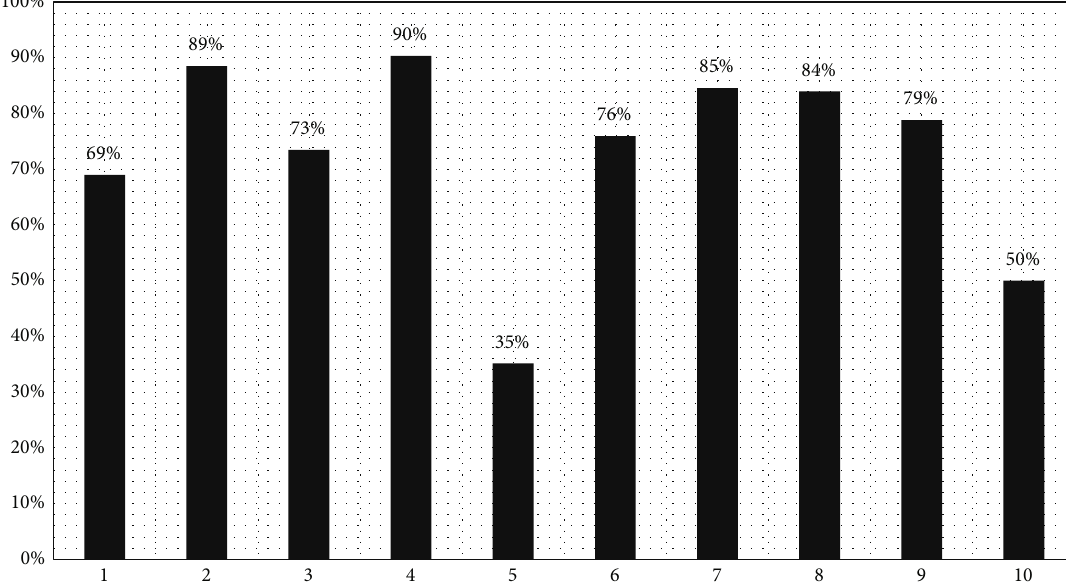
Figure 5: Jakob Nielsen ’ s interface evaluation.